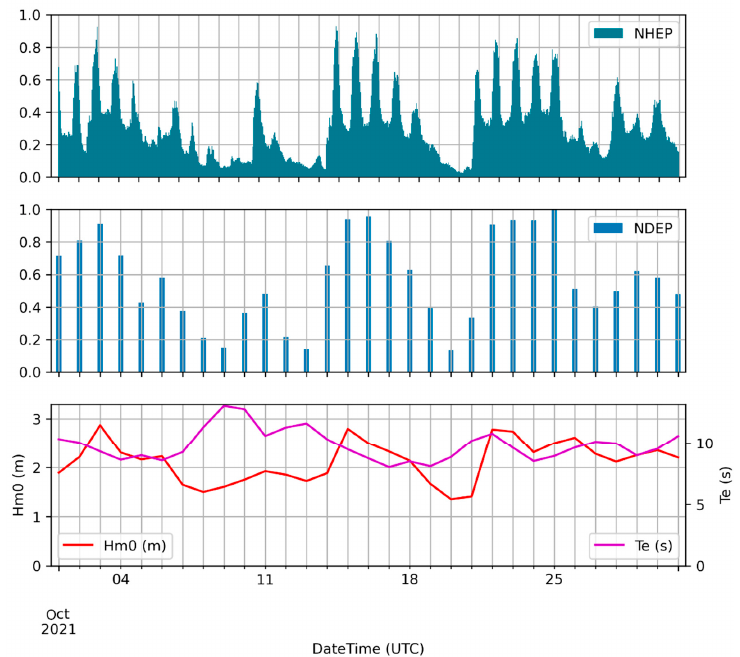
Figure 10. Upper and middle panel: nondimensionalized hourly and daily energy produced in October 2021, respectively. Lower panel: daily wave height Hm0 and energy period Te obtained from the WW3 hindcast for the same period.